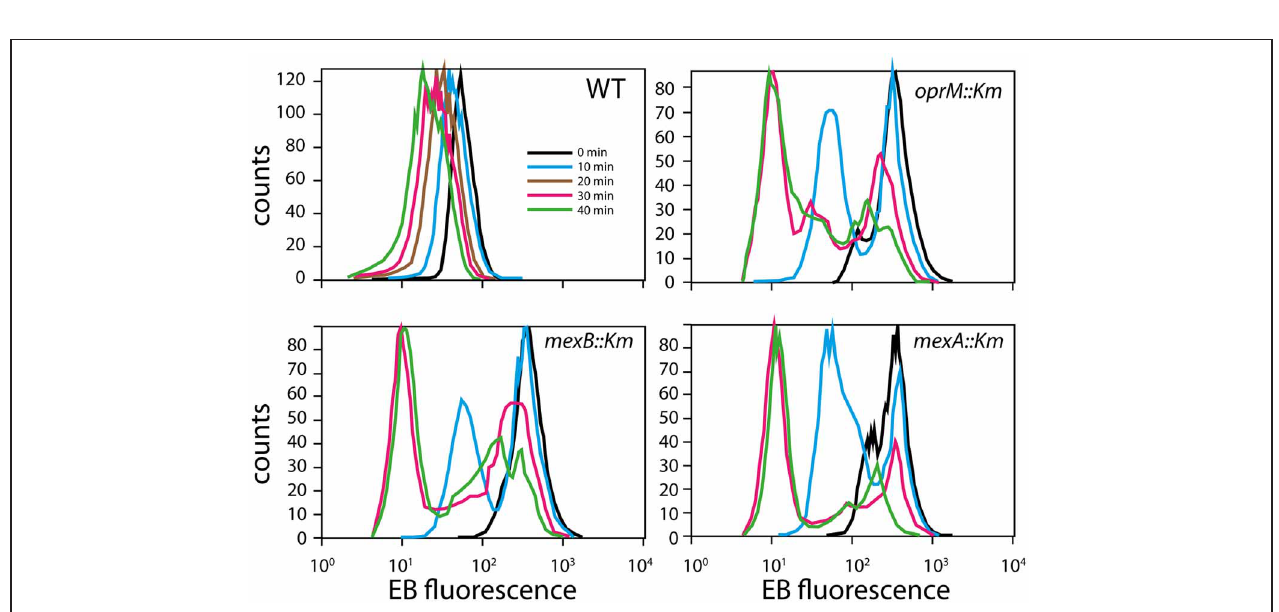
FIGURE 6 | EB efflux in P. azelaica HBP1 and the selected transposon mutants. Cells were loaded with 10 μ M EB and then resuspended in growth medium w/o EB. Graphs display the distribution of EB fluorescence levels in cells at times 0, 10, 20 (for wild-type only), 30, and 40min.